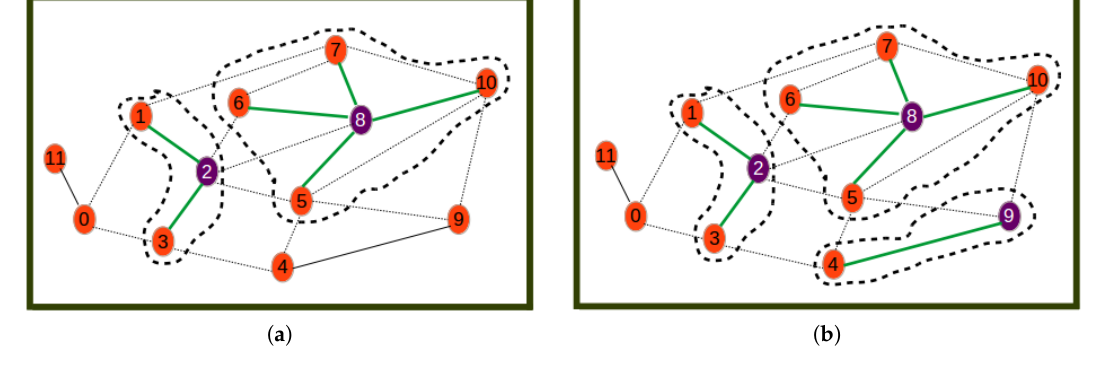
Figure 5. Processing steps. ( a ) Step 2; ( b ) Step